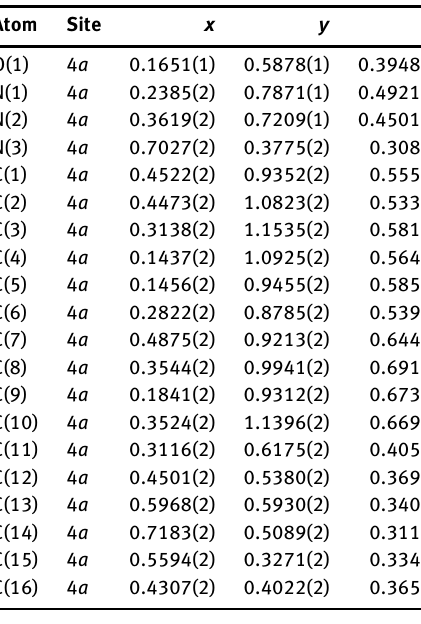
Table 3: Atomic displacement parameters (Å 2